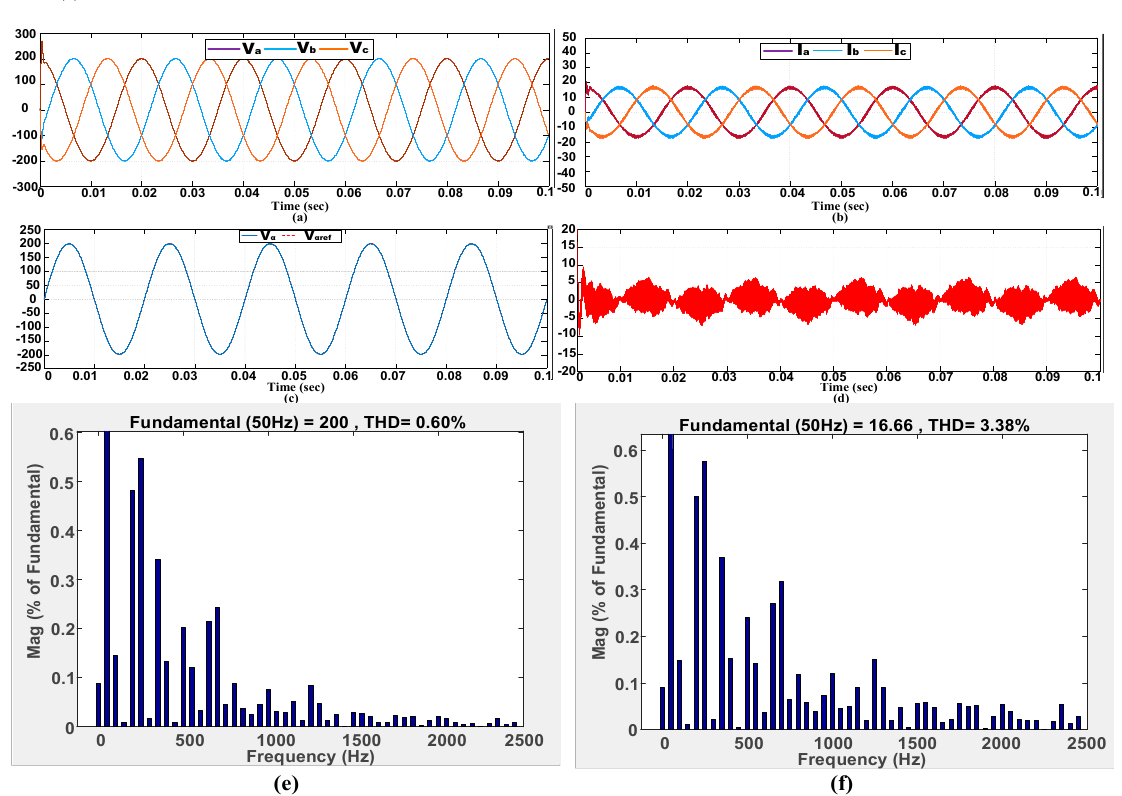
Figure 7. Simulation results with the DB predictive controller in steady-state condition. ( a ) Output voltage ( b ) Load current, ( c ) α -frame voltage waveform, ( d ) Voltage tracking error, ( e ) Voltage THD, ( f ) Current THD.